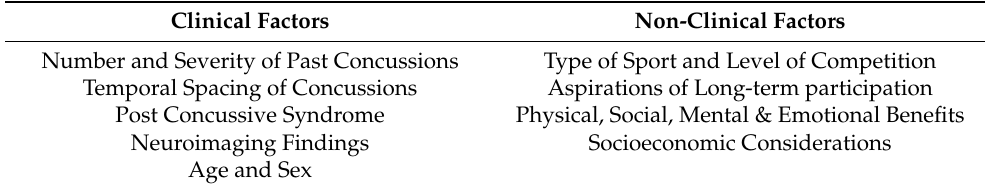
Table 1. Factors to consider when to retire a child athlete from sports post-concussive